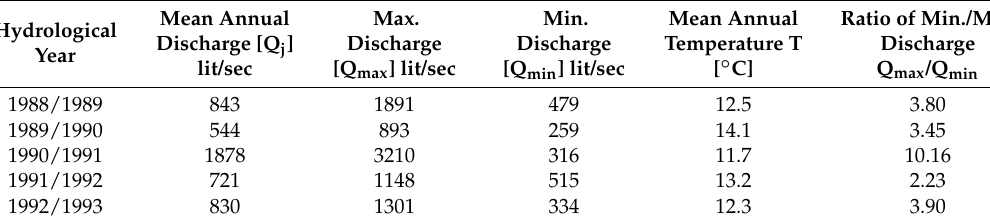
Table 1. Discharge and temperature values of Kefalovriso spring.